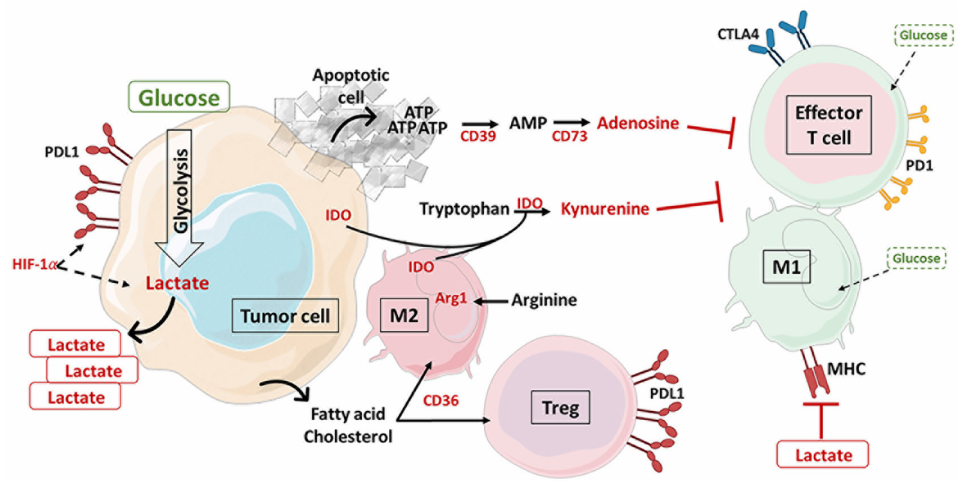
Figure 4. Metabolites produced in the tumor microenvironment (TME) and their impact on antitumor immune cell exhaustion. Metabolic competition with cancer cells affects the supply of nutrients such as glucose and amino acids to antitumor cells, while T regulatory lymphocytes (Tregs) and M2 macrophages (M2) can consume lipids and lactate present in the TME. Many molecules secreted by immune cells or cancer cells participate in immunosuppression. In cancer cells, lactate produced in large quantities by activation of HIF-1 α -dependent glycolysis inhibits MHC and consequently the activation of effector T cells. The released ATP is converted by both CD39 and CD37 ectonucleotidases into adenosine which binds to its A2A receptor to affect T cell functions. Indolamine 2,3-dioxygenase (IDO) exerts immunosuppressive functions, both by the deprivation of tryptophan and by the binding of kynurenine on aryl hydrocarbon receptor (AhR). M2 macrophages deplete arginine from the environment via the enzyme arginase 1 (Arg1), affecting cytokine secretion and T cell receptor (TCR) expression. Metabolic changes in the TME promote the expression of immune checkpoints to reinforce the blockade of potential antitumor action, suppress the antitumor response and favor the development of Tregs. AhR: aryl hydrocarbon receptor; AMP: adenosine monophosphate;